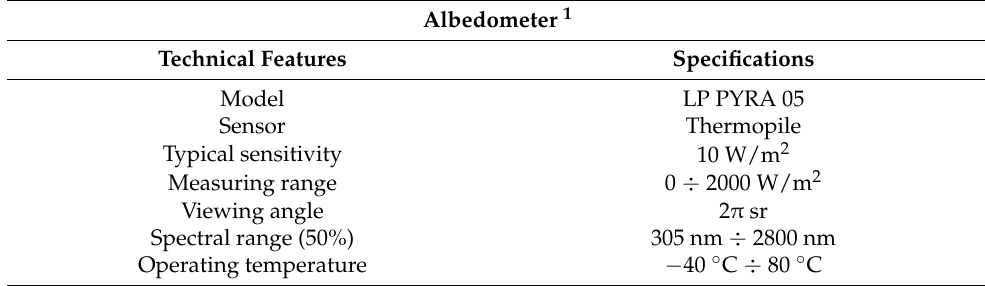
Table 2. Technical features of the albedometer LP PYRA